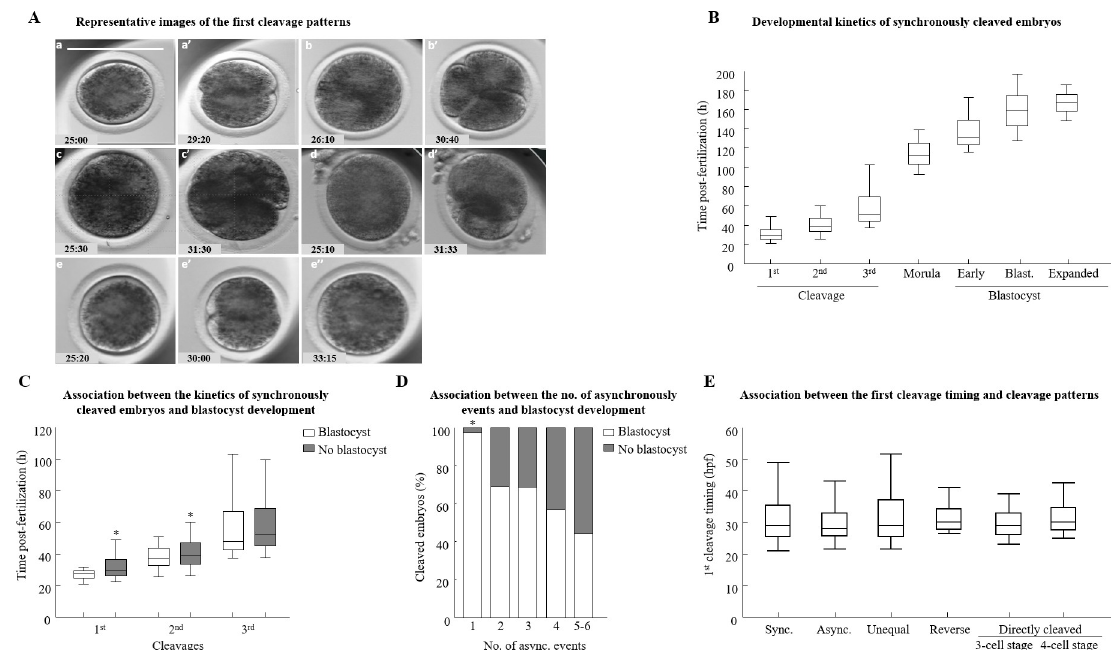
Fig 2. Developmental kinetics of cleaved bovine embryos. Cumulus-oocyte complexes (COCs) were in-vitro-matured, fertilized, and individually cultured for 190 h in CultureCoin dishes in an incubator equipped with a time-lapse system. Embryonic development was continuously monitored with image acquisition every 5 min. (A) Representative images of the morphological categories of embryos at the first cleavage: normally cleaved embryos are characterized by two equal-sized blastomeres (putative zygote after fertilization) (a), after normal cleavage (a’); directly cleaved embryos are characterized by direct cleavage from 1 cell (putative zygote after fertilization) to 3 blastomeres (b), after cleavage into a 3-cell-stage embryo (b’); or direct cleavage from 1 cell to 4 blastomeres (c and c’); an unequally cleaved embryo is characterized by two blastomeres of unequal size (d”); a reverse-cleaved embryo is characterized by reduced number of blastomeres through the first division (e and e’), and after merging to 1 cell (e”). The precise time (h:min) post-fertilization is presented in the lower-left corner of the pictures. Scale bar = 100 μ m. (B) For each embryo in the synchronously cleaved embryos, the cleavage timing post-fertilization of the 1 st , 2 nd , and 3 rd cleavages, and the time of morula, early blastocyst, and blastocyst formation, as well as the blastocyst expansion were recorded. Data are presented in whisker plots. Boxes indicate the 25th and 75th percentiles, and the middle horizontal line indicates the median. Whiskers indicate the maximum and minimum values within the acceptable range defined by the two quartiles, n = 431 embryos. (C) Presented is the cleavage timing post-fertilization (1 st , 2 nd , and 3 rd cleavages) of synchronously cleaved embryos that further developed or did not develop to the blastocyst stage (the white or gray column, respectively). The line inside the box is the median; the lower hinge of the box indicates the 25th percentile, and the upper hinge indicates the 75th percentile. The upper whisker indicates the 95th percentile values and the lower whisker indicates the 10th percentile values for the cleaved embryos that further developed or did not develop to the blastocyst stage. The Kruskal Wallis test, followed by the Wilcoxon test pairwise comparisons, was used to compare the median value in the first, second, and third cleavages. � P < 0.05. (D) The pattern of asynchronous embryonic division was divided into six distinct classes, according to the number of asynchronous events expressed (i.e., one to six events). The proportion of embryos that either developed or did not develop to blastocysts was analyzed by the Chi-squared test was followed by Pearson’s test. � P < 0.05; n = 271 cleaved embryos. (E) Presented is the time of the first cleavage for all the cleavage patterns. The timing of the 1 st divisions in synchronously (Sync), asynchronously (Async), and abnormally cleaved embryos was recorded. The line inside the box is the median; the lower hinge of the box indicates the 25th percentile and the upper hinge indicates the 75th percentile. The upper whisker indicates the 95th percentile values and the lower whisker indicates the 10th percentile values. n = 656 embryos. The Kruskal Wallis test, followed by the Wilcoxon test, was used to compare the median value in the first cleavage between